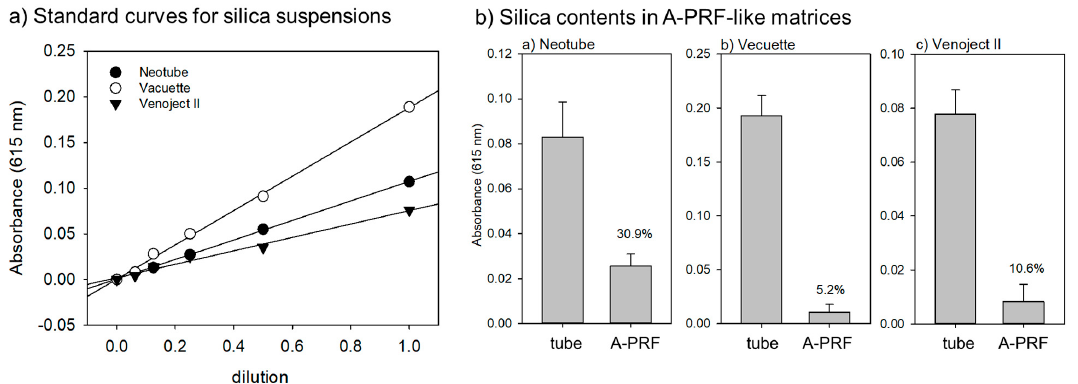
Figure 5. ( a ) Representative standard curves for silica contents and ( b ) contents and percentages of silica microparticles contained in A-PRF-like matrices versus whole contents of pre-use tubes. n = 8.